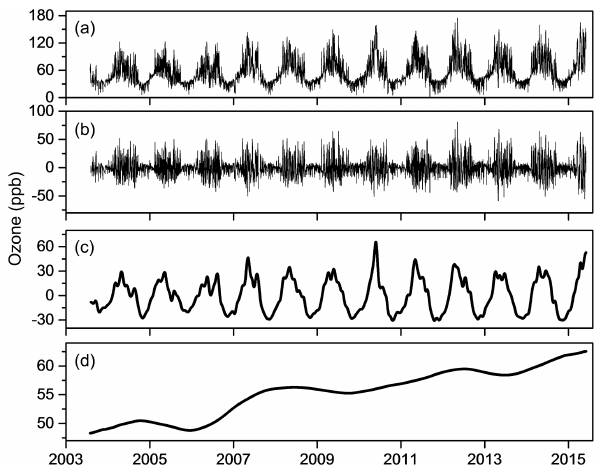
Figure 2. Separated time series of MDA8 values of ozone at SDZ: (a) the original data; (b) the short-term component, W(t) ; (c) the seasonal component, S(t) ; (d) the long-term component, e(t) .